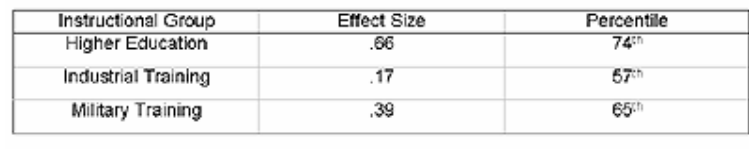
Table 2. Average effect sizes for three instructional groups using